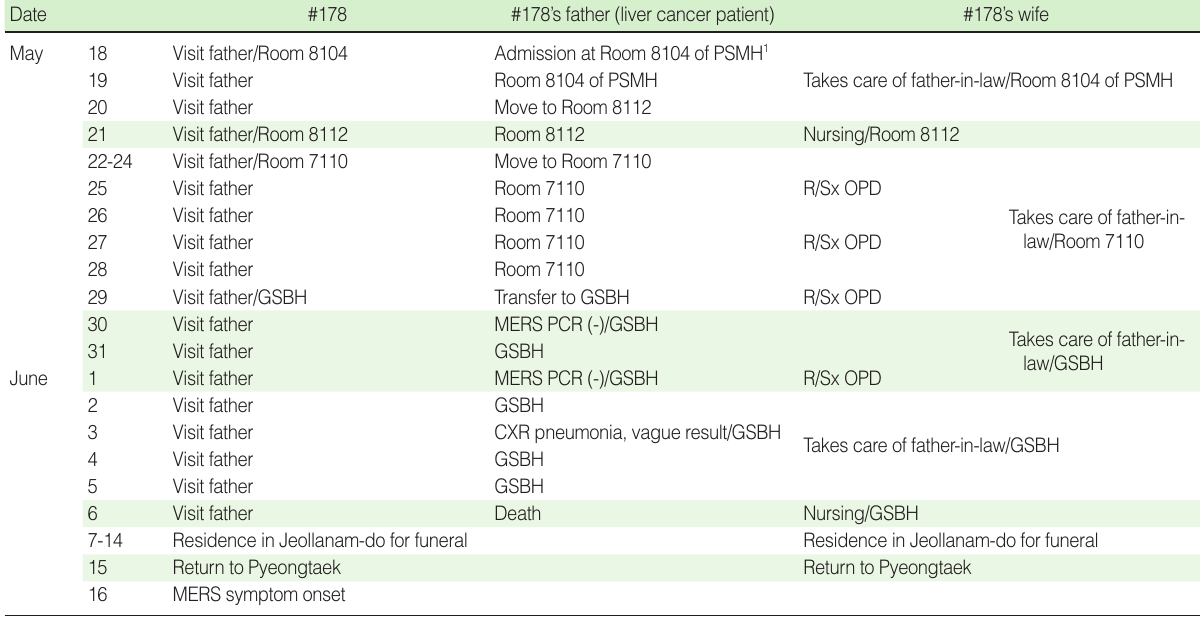
Table 2. Flow chart of the 178th MERS case and his family